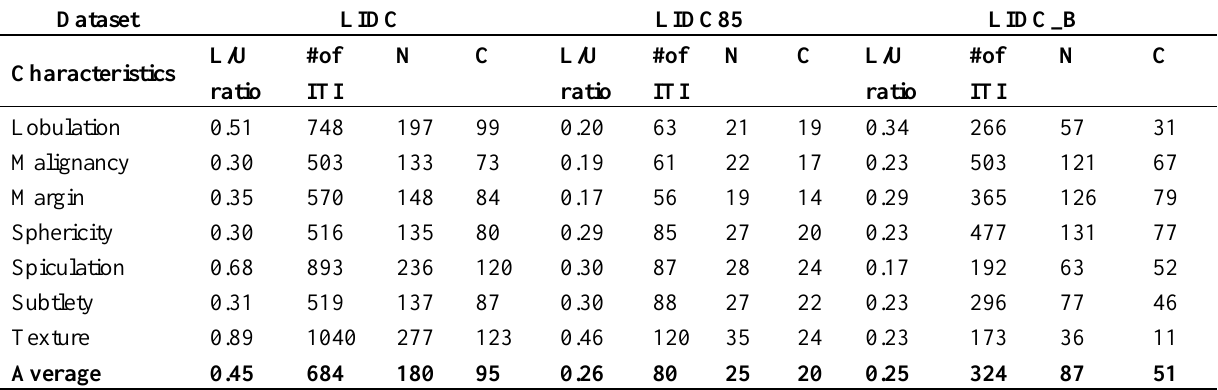
Table 5. Structure of the initial training data for all three datasets; L/U ratio represents the ratio between the labeled versus unlabeled data; ITI stands for initial training instances, N for the number of nodules and C for the number of cases.